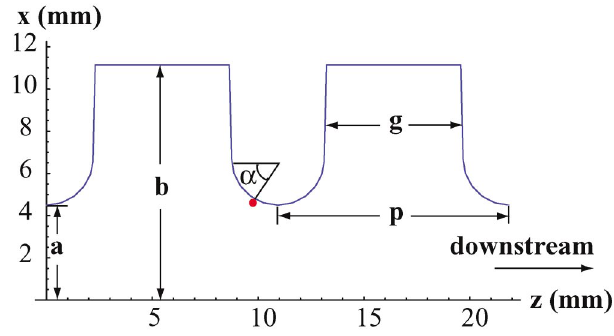
FIG. 1. (Color) Two cells of the model geometry, showing the angle (cid:17) (the emission point is in the x - z plane and indicated by the red dot).